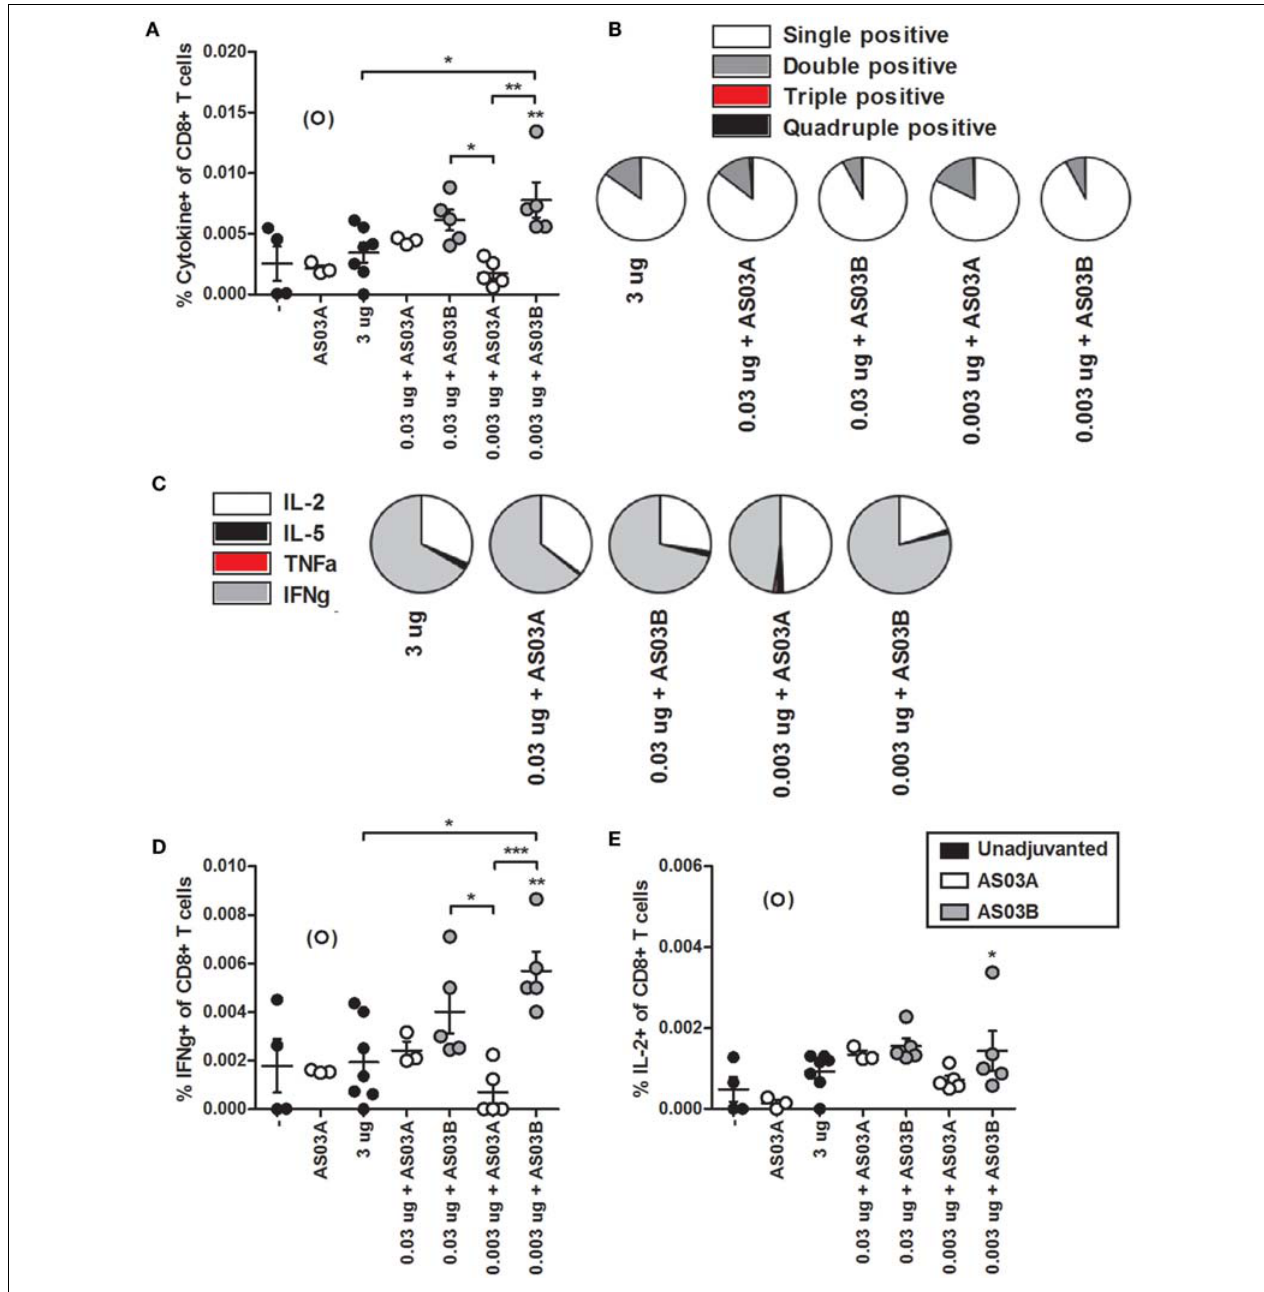
FIGURE 6 | Influenza-specific cytokine-producing CD8 + T cells in splenocytes after two immunizations of unadjuvanted A/Uruguay/716/2007 H3N2 split vaccine or AS03-adjuvanted dose-sparing vaccines . BALB/c mice were immunized intramuscularly on days 0 and 21, and splenocytes were isolated from individual mice on day 42. Splenocytes were stimulated ex vivo with A/Uruguay H3N2 split vaccine and co-stimulatory antibodies, then analyzed by flow cytometry for CD8 + T cells that produced a combination of IL-2, IL-5, IFN γ , or TNF α cytokines. The gating strategy is described in Figure S2 in Supplementary Material and representative dot plots are shown in Figure S4 in Supplementary Material. The percentage of total responding CD8 + T cells